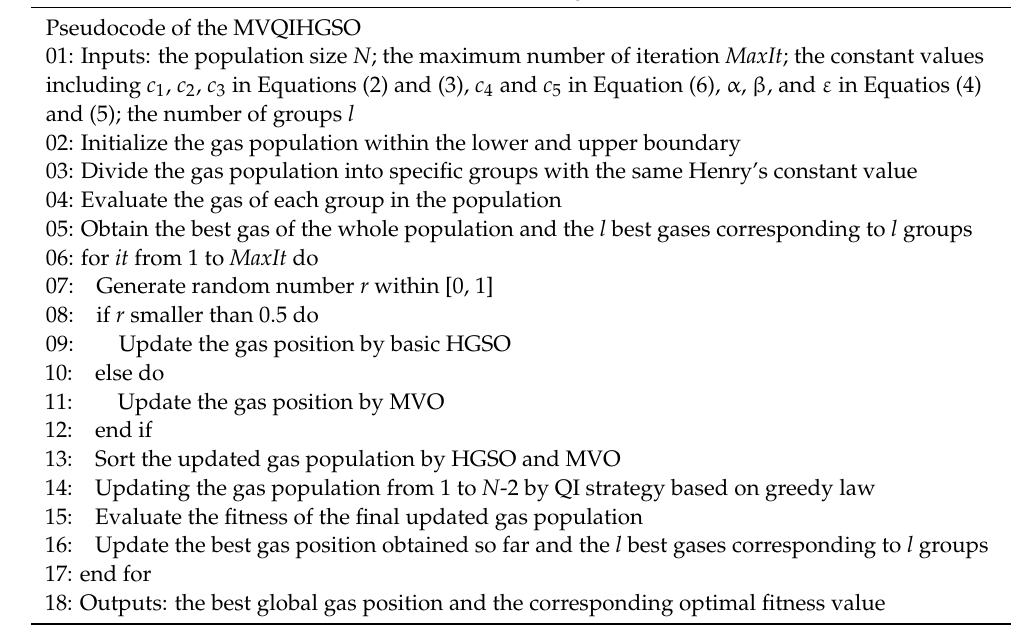
Algorithm 1. Detailed information of MVQIHGSO algorithm. Pseudocode of the